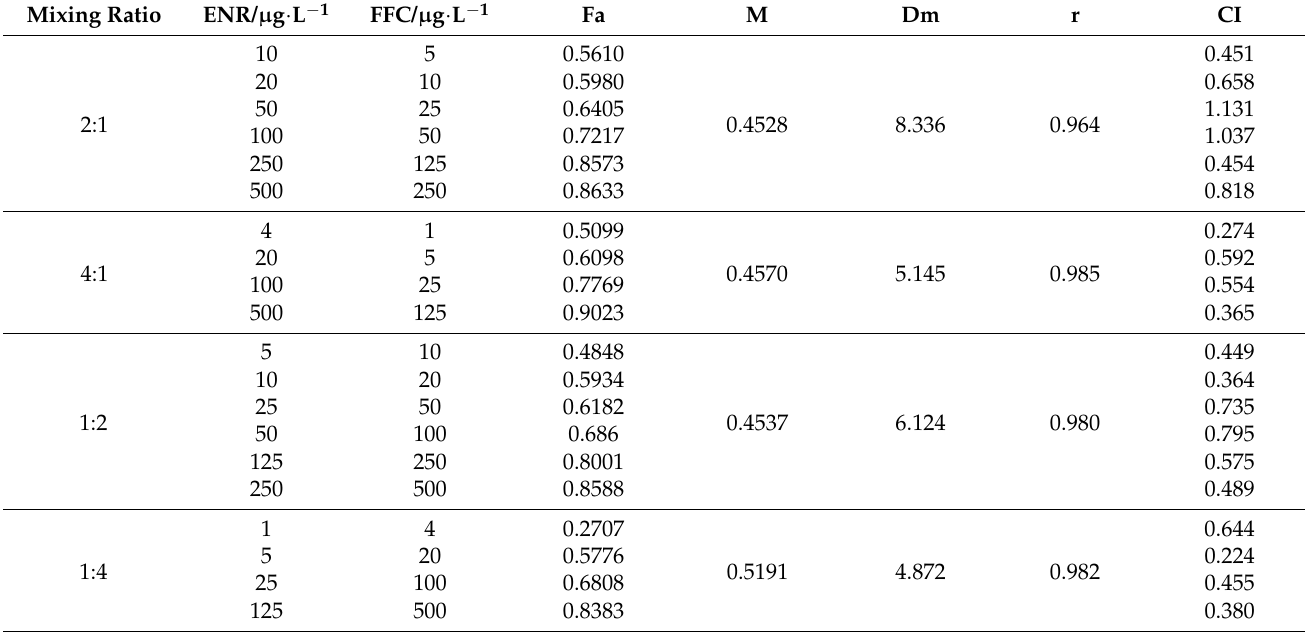
Table 6. CI values and parameters of median-effect plots of binary drug combination enrofloxacin and sulfamethazine (C) (at ratios of 2:1, 4:1, 1:2, and 1:4) against THLE-2 cells after 72 h